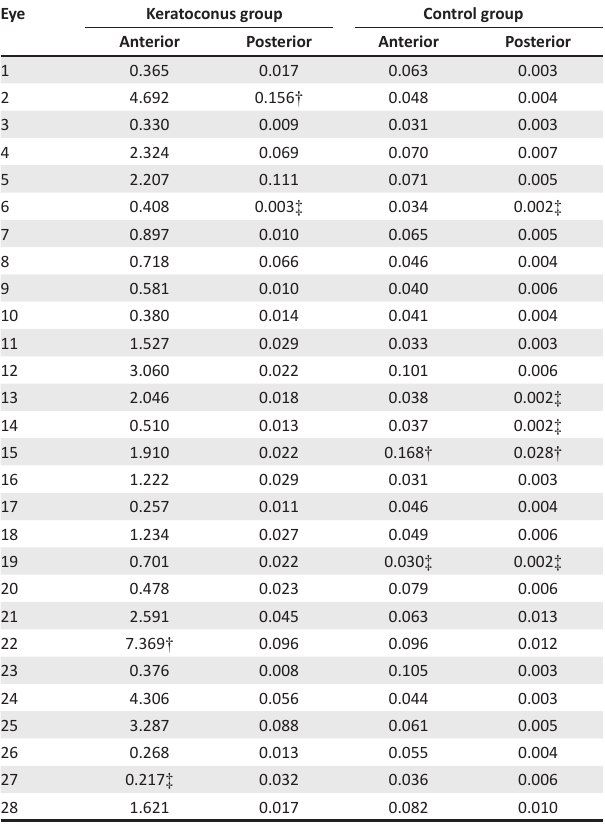
TABLE 2: Distribution ellipsoid (95 % ) volumes for anterior and posterior central corneal power for 28 eyes with keratoconus and 28 control eyes. Maxima and minima are indicated in red and blue, respectively. Medians and quartile deviations (= 0.5 interquartile range) for ellipsoid volumes can be found in Table 3. Eye Keratoconus group Control